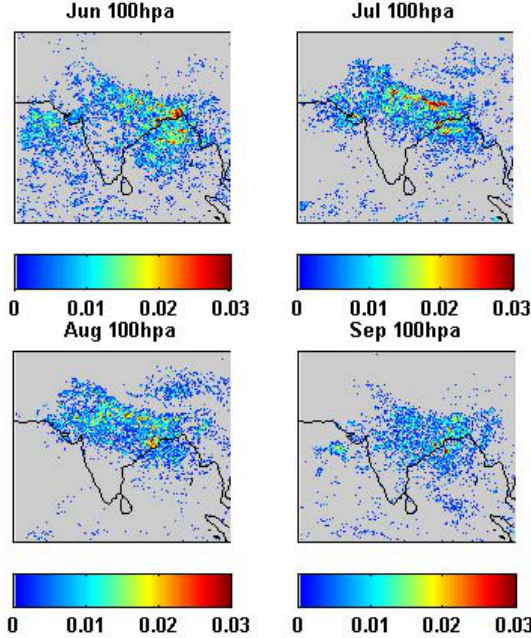
Fig. 7. The composite of cloud amount at 100hPa from seen from the MODIS averaged over 2003 to 2008 (for clouds with optical thickness greater than 23). Note that the color-scale is identical to that of Fig. 3, 100hPa data.